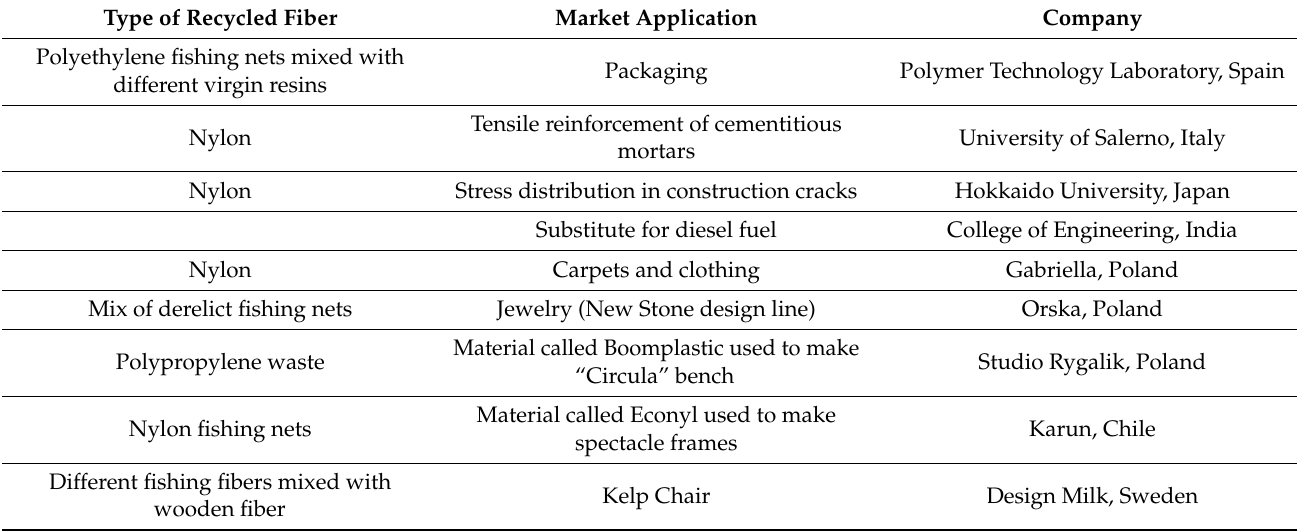
Table 1. Examples of different market applications for